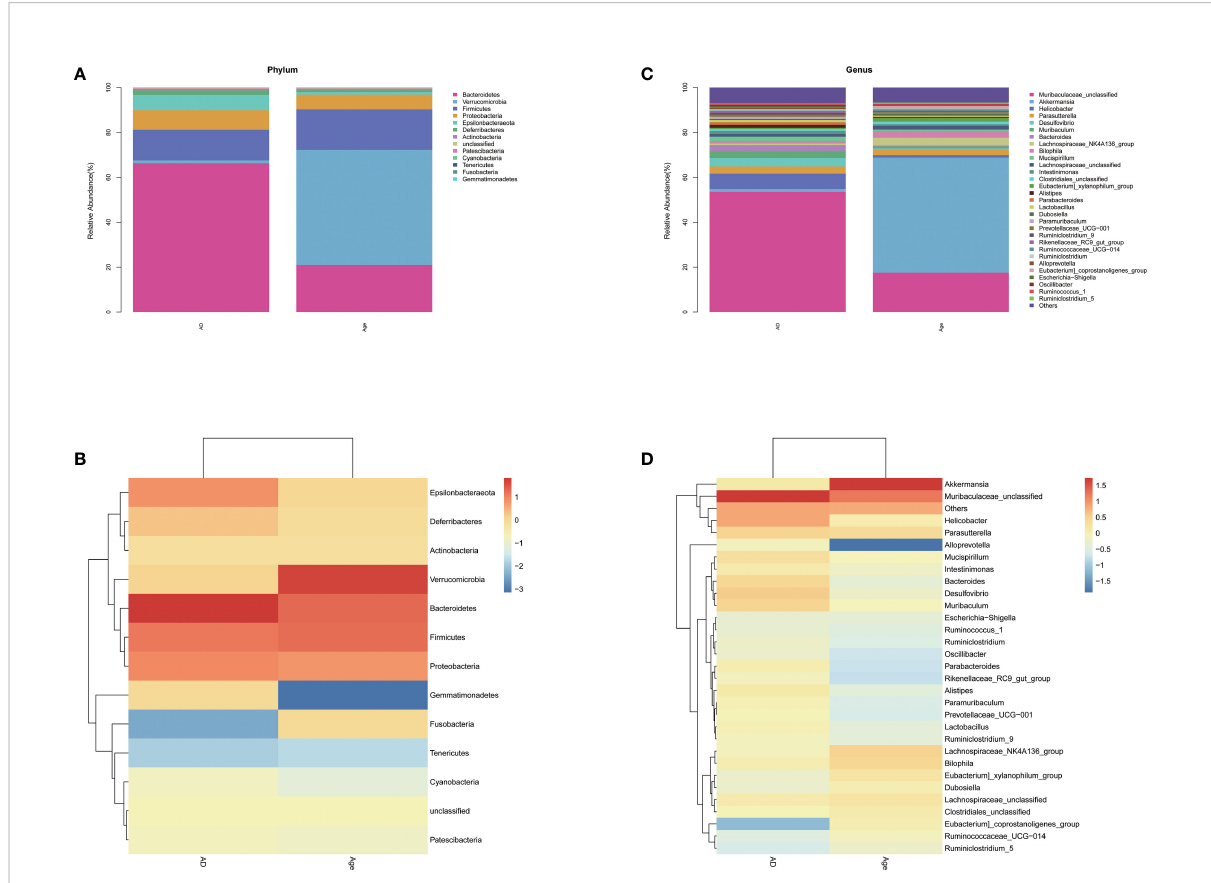
FIGURE 3 Relative abundance. Relative microbiota distribution between the two groups. (A, B) phylum level. (C, D) genus